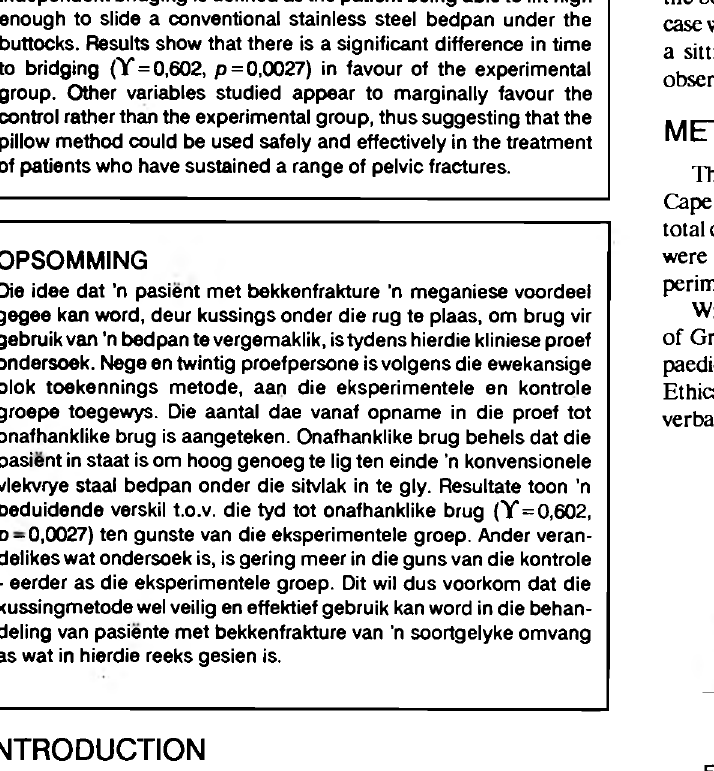
FIG 1: PILLOW POSITION FOR BED-PAN FOR THIS